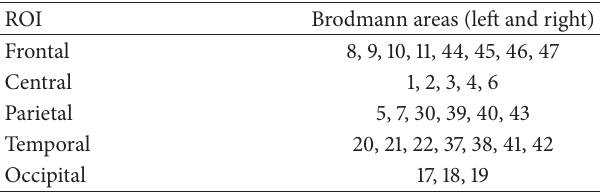
Table 2: Brodmann areas into the regions of interest (ROIs). Brodmann areas (left and